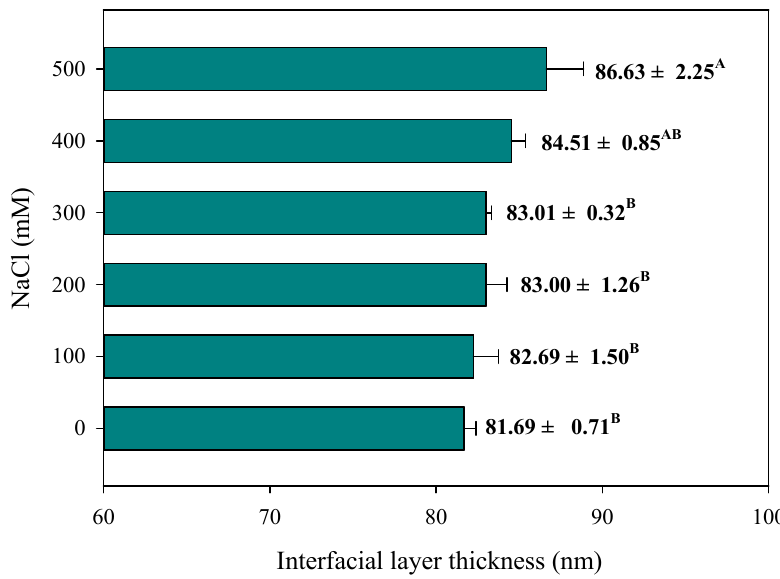
Figure 6. Effects of NaCl concentration on the interfacial layer thickness of filled hydrogels. Different letters from A to B indicate significant differences at different NaCl concentration ( p < 0.05).